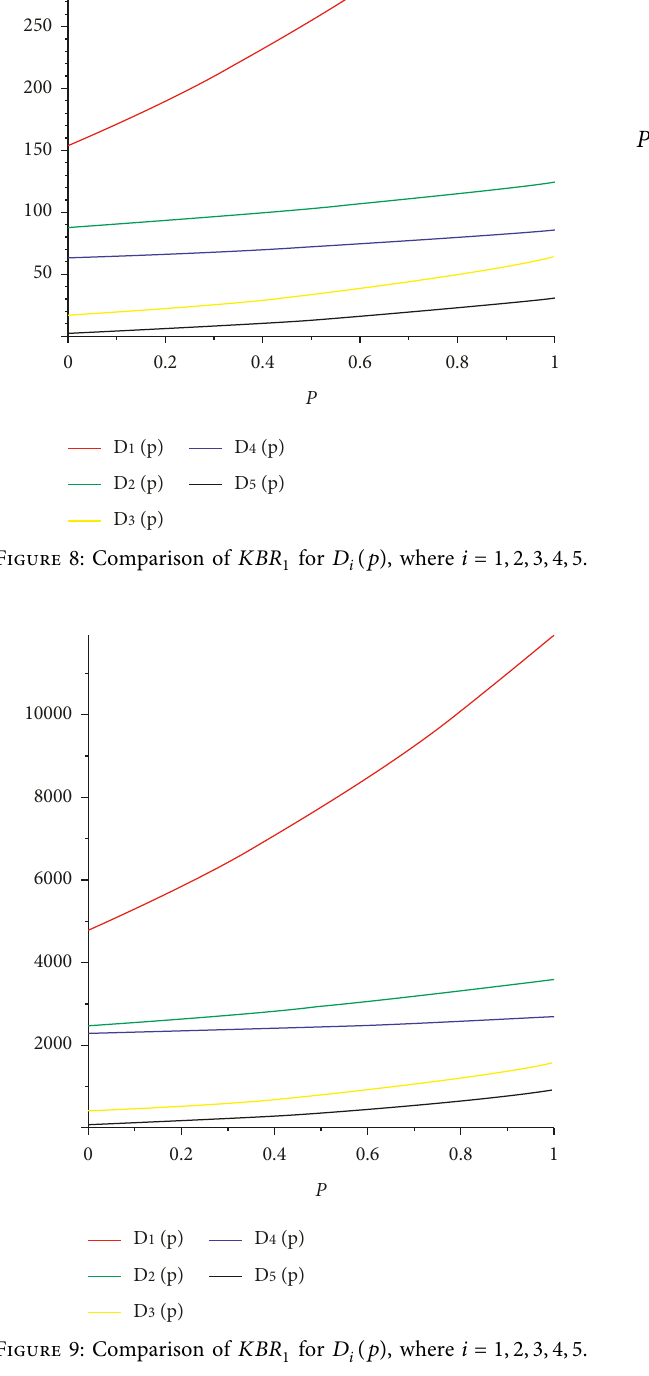
for D i ( p ) , where i � 1 , 2 , 3 , 4 , 1